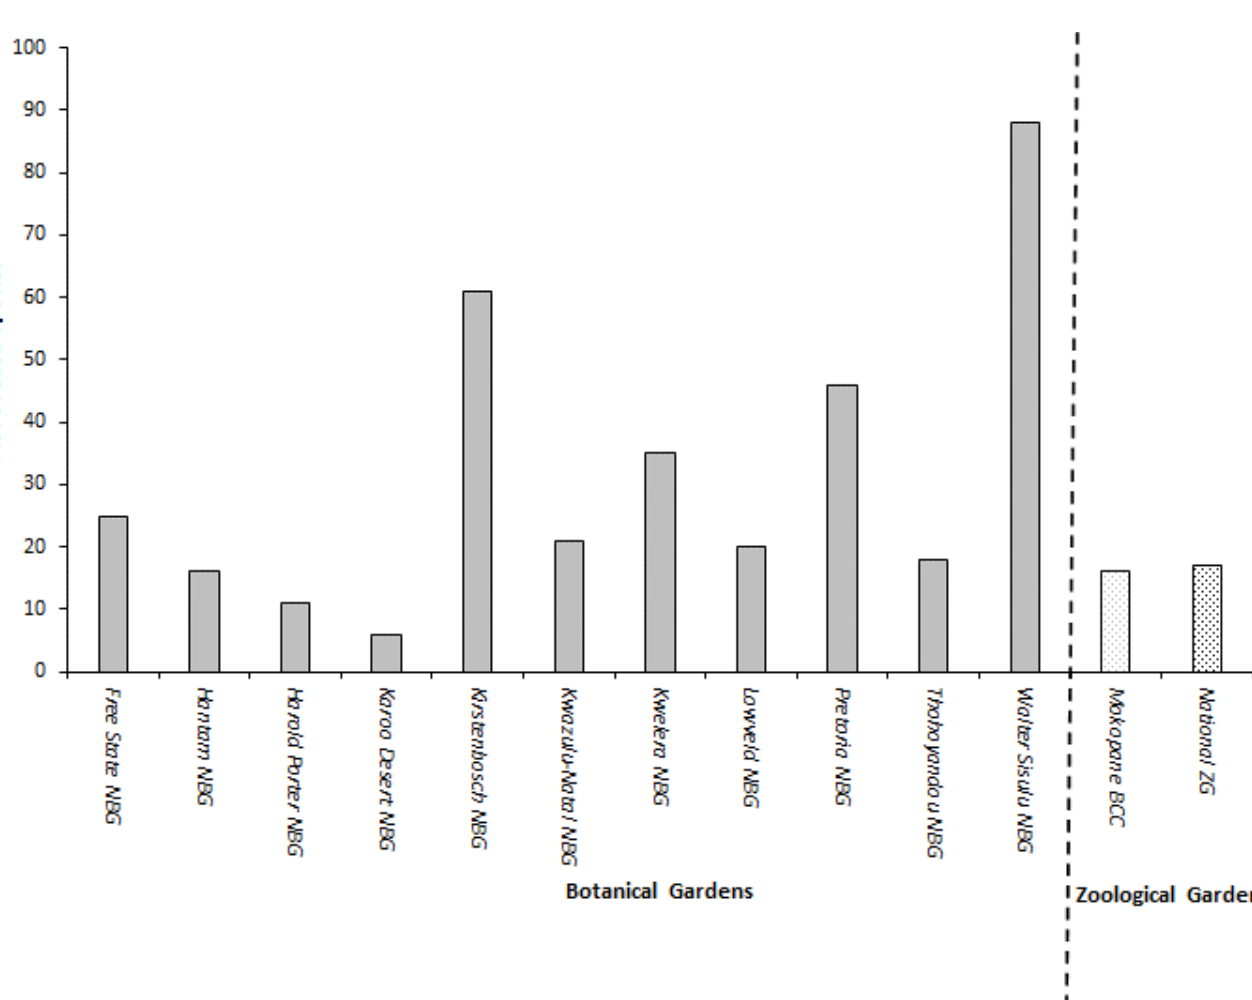
Figure 2. The number of alien plant species recorded in SANBI gardens.